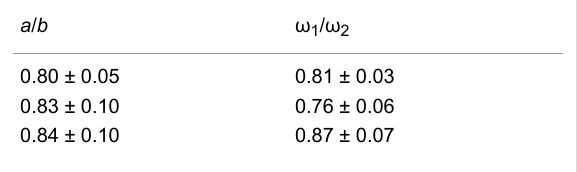
Table 1: Ratios of resonance frequencies ω 1 / ω 2 show consistency with corresponding ratios a/b of NW side